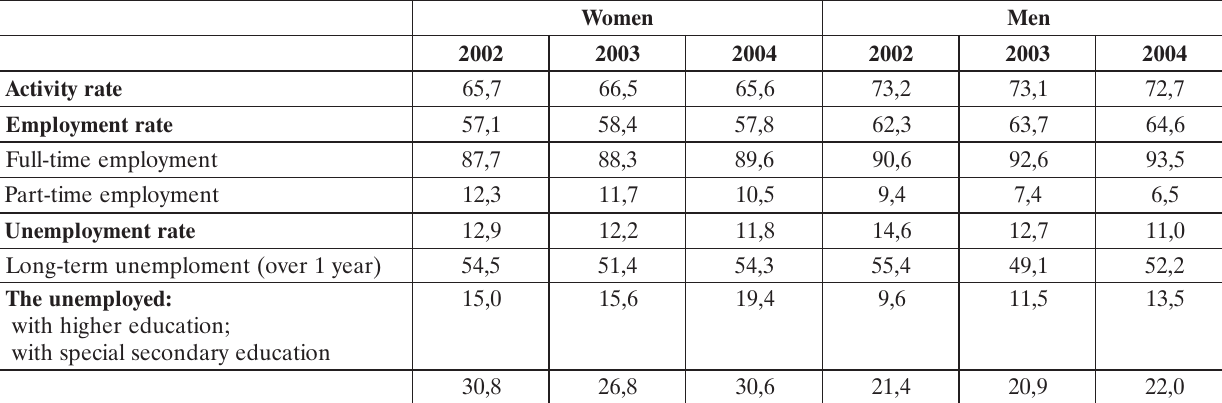
Table 3. Employment rates of Lithuania’s men and women,